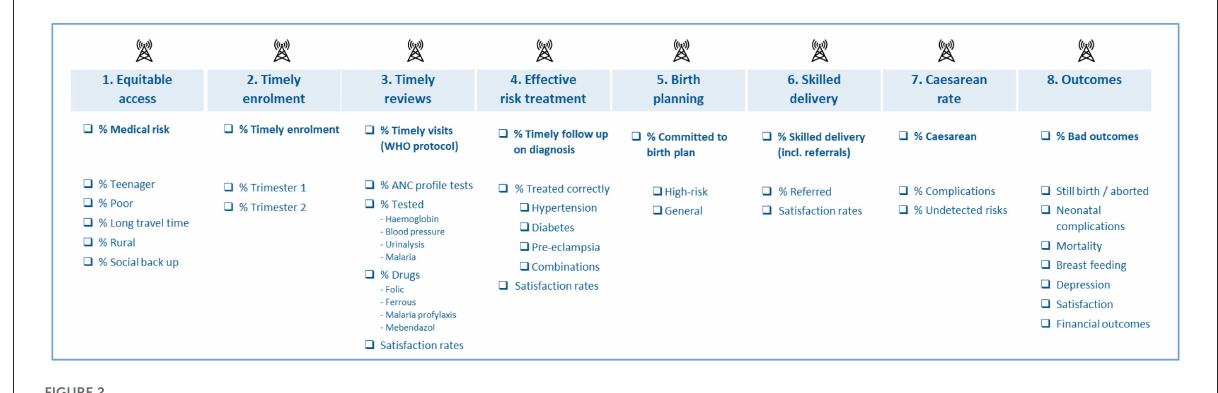
FIGURE2 Key performance data collected by the